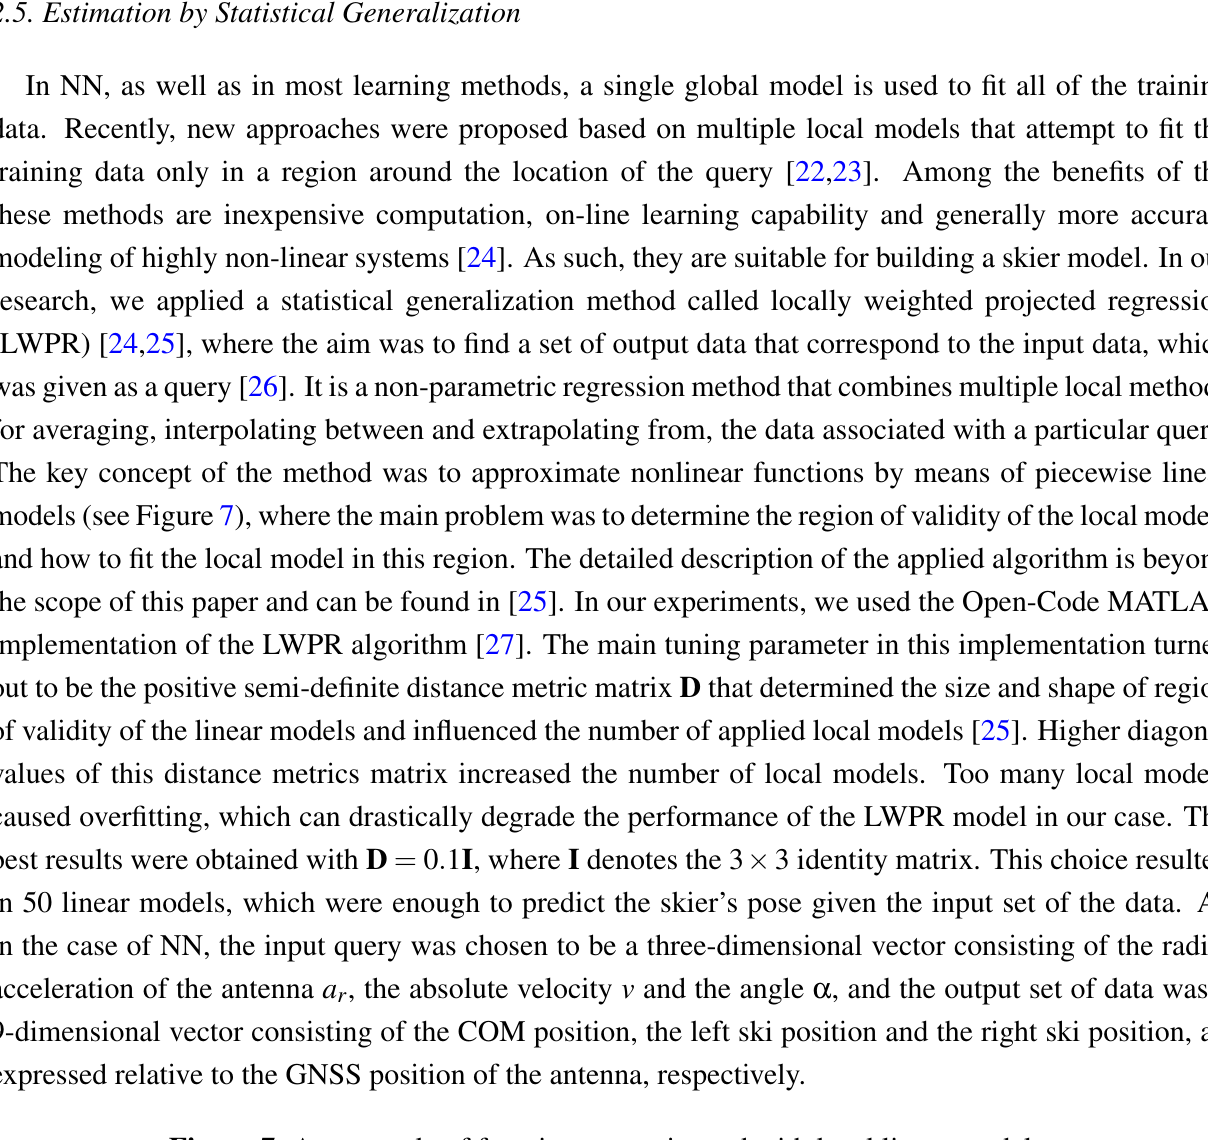
Figure 7. An example of function approximated with local linear